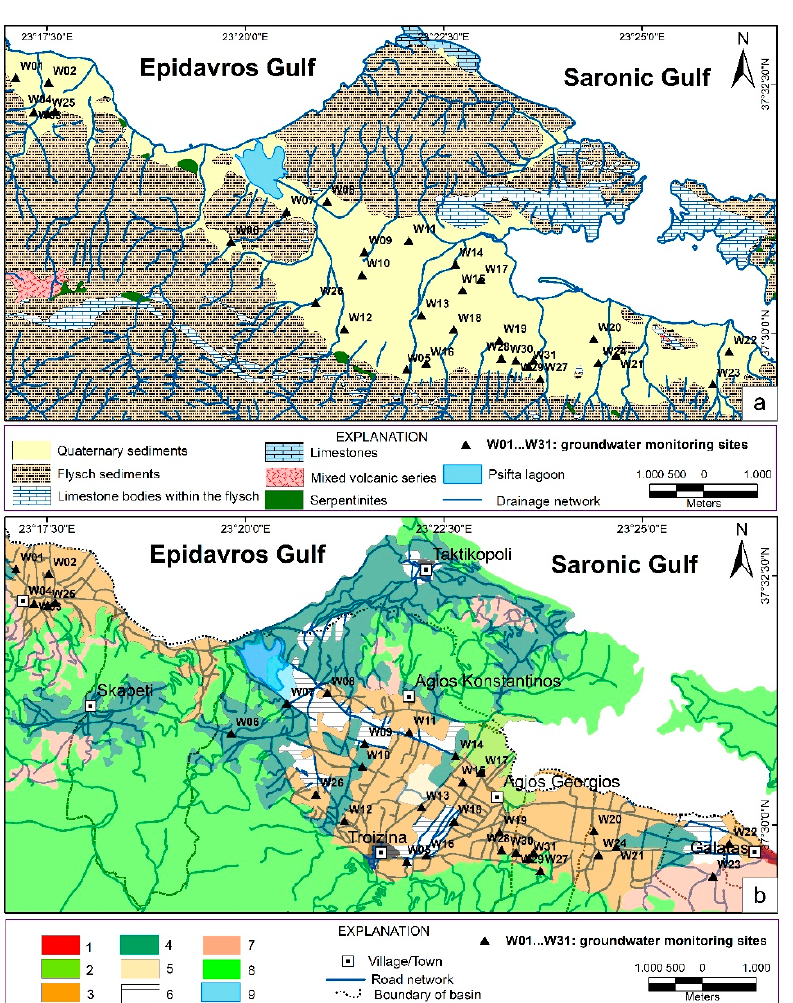
Figure 2. Map showing study area and groundwater monitoring sites compared with ( a ) geology and ( b ) land use [(1) urban fabric, (2) non-irrigated arable land, (3) fruit trees (orange trees, citrus trees), (4) olive groves, (5) annual crops associated with permanent crops, (6) complex cultivation patterns, (7) agricultural land, (8) shrubby and/or herbaceous vegetated areas, and (9) Psifta lagoon].